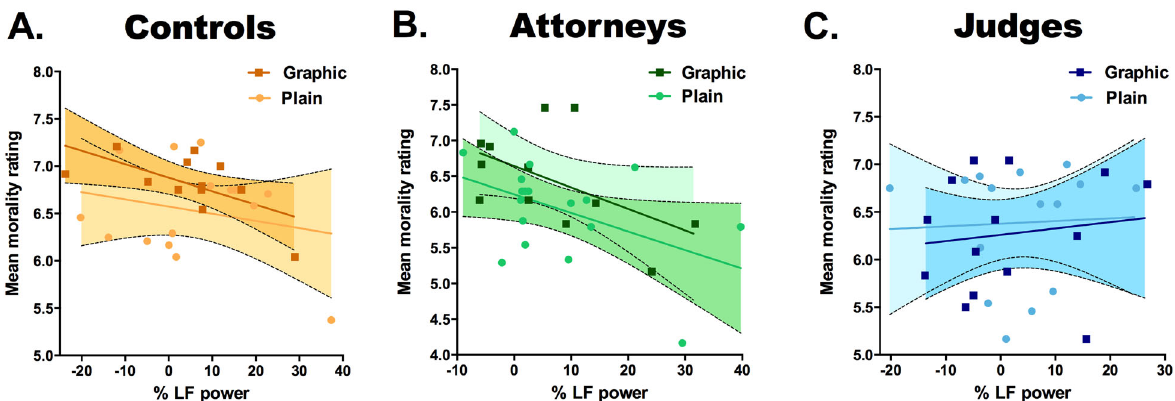
Fig. 3 Association between mean morality ratings and emotional activation as indexed by the percentage change of power in the low frequency (LF) band. There was a signi fi cant correlation between LF power and mean morality ratings only for control participants that read gruesome descriptions of harm, but not for those that read plain descriptions. a This association was not signi fi cant in attorneys b or judges c who read either plain or gruesome descriptions. Depicted in the scatter plots are the regression lines and 95% con fi